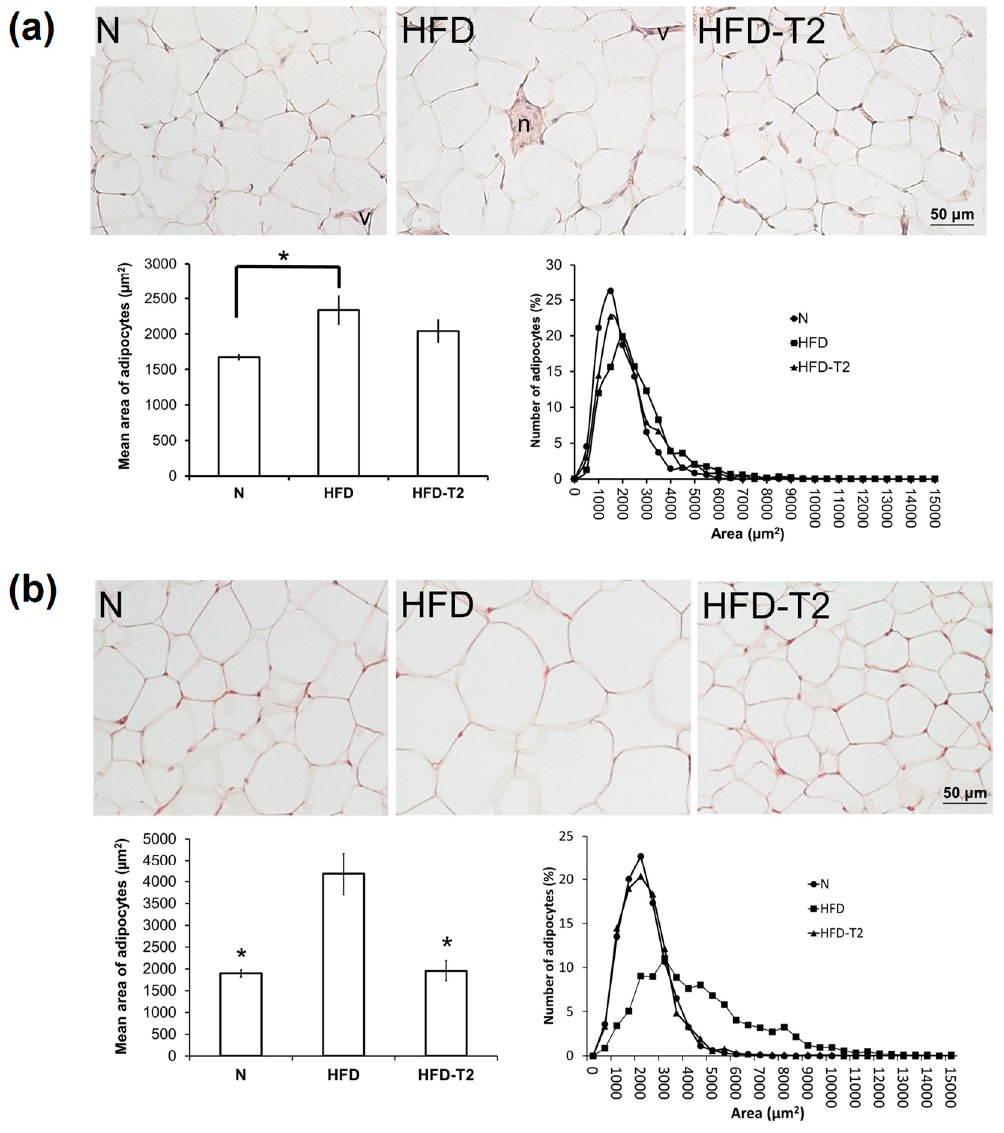
Figure 1. Histological and morphometrical analysis of VAT after administration of 3,5-T2 to rats simultaneously fed a high-fat diet (HFD-T2) for 1-week ( a ), and for 2 weeks ( b ), when compared to the HFD-fed (HFD) rats and chow-fed (N) controls. Representative staining of 4 independent treatments are shown. Abbreviations: n = nerve, v = vessel. Shown are the mean values ± SEM ( n = 4). * p < 0.05 vs. HFD.